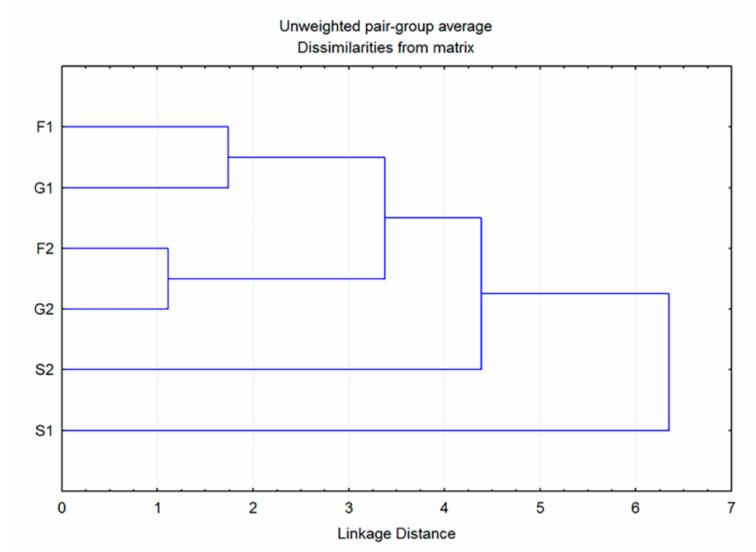
Figure 6. Dendrogram obtained by cluster analysis of 6 groups of Clinopodium pulegium plants based on 18 HS